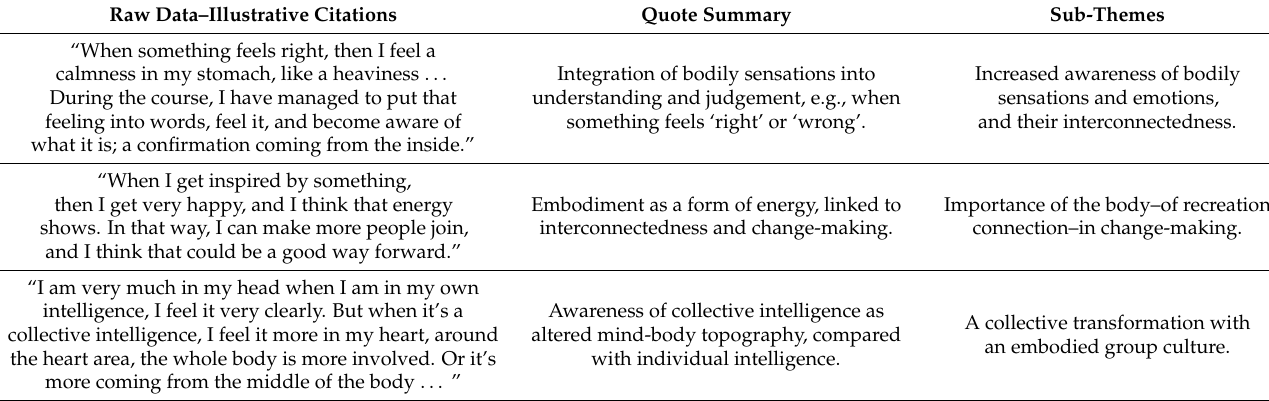
Table 3. Theme 3–Embodied transformation–individual and collective awareness and growth.